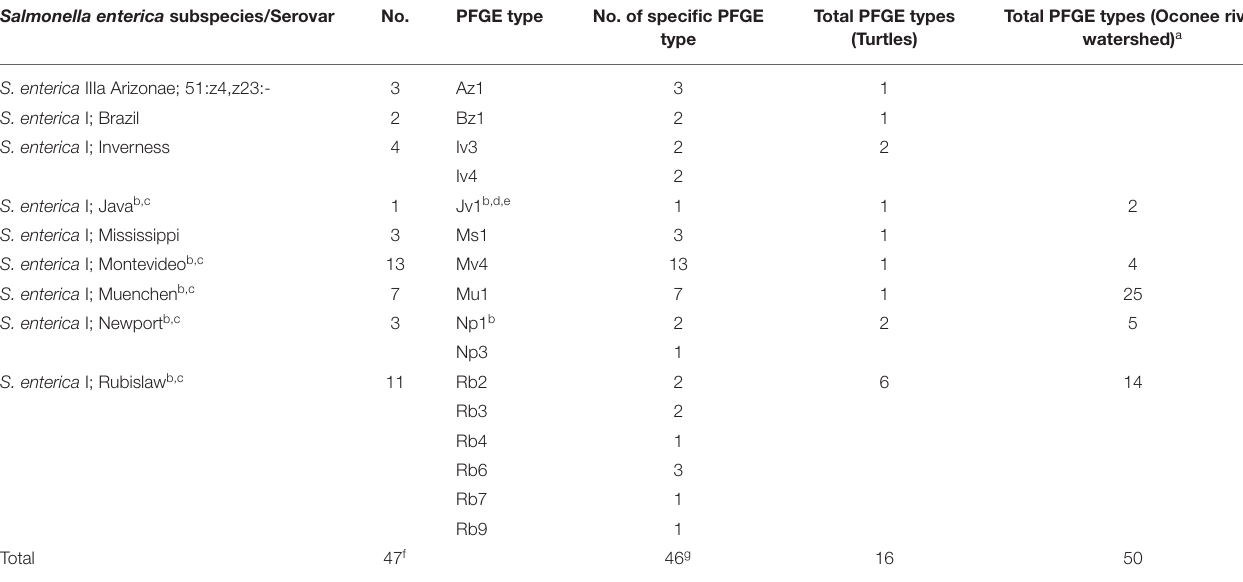
TABLE 2 | Salmonella enterica serovar and strain diversity among turtles sampled in Athens, Georgia. Salmonella enterica